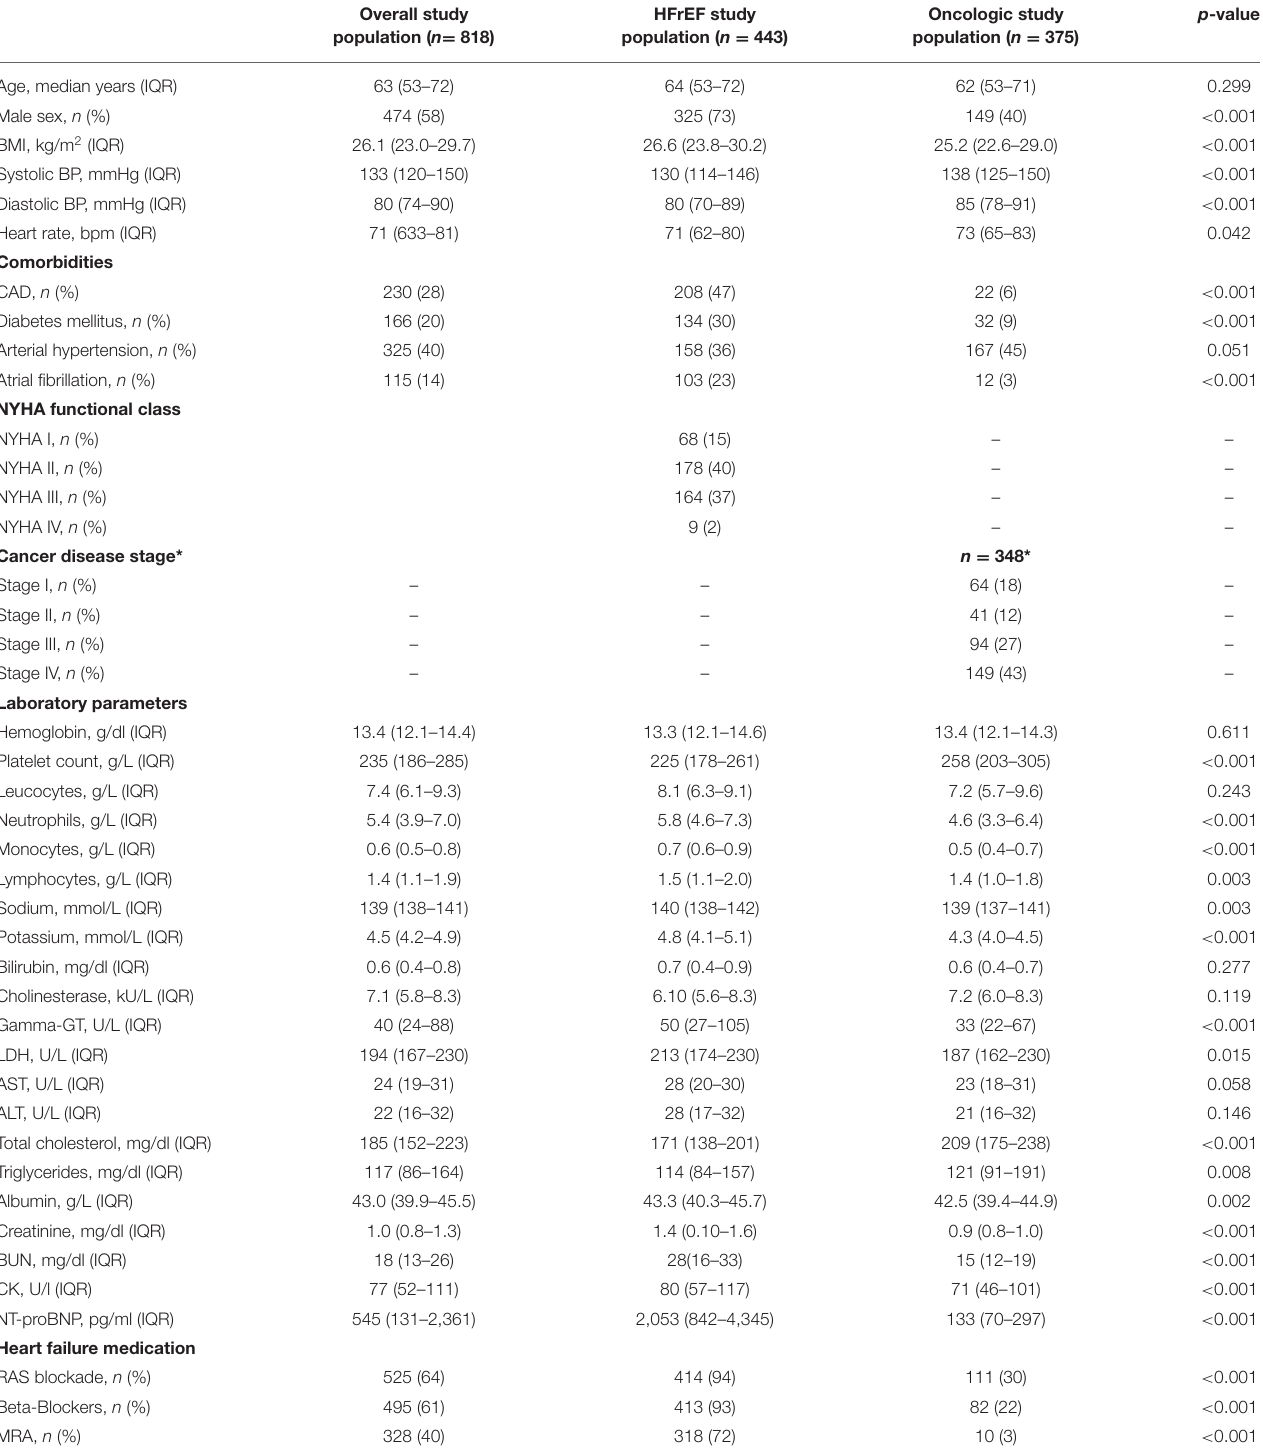
TABLE 1 | Baseline characteristics of the two study populations.